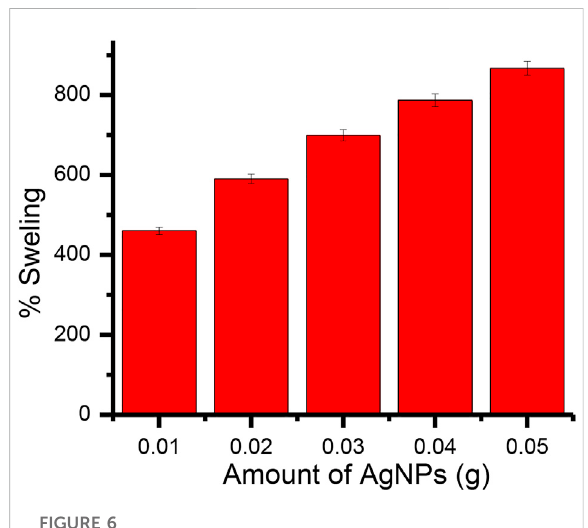
FIGURE 6 The impact of AgNPs on the swelling of Gk-cl-poly(AA)AgNP